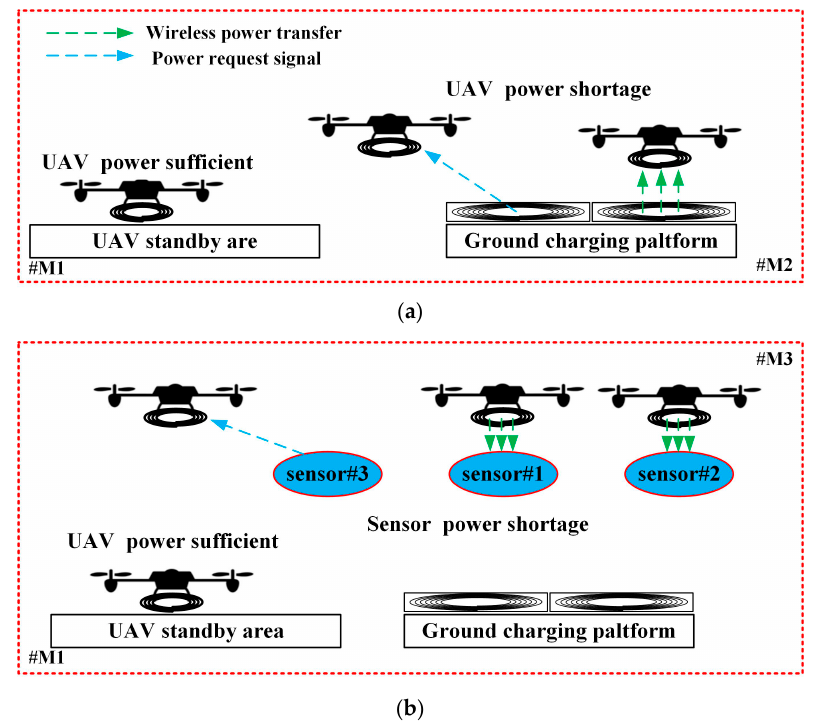
Figure 1. Working modes ( a ) #M2 and ( b ) #M3 of bidirectional wireless charging system.